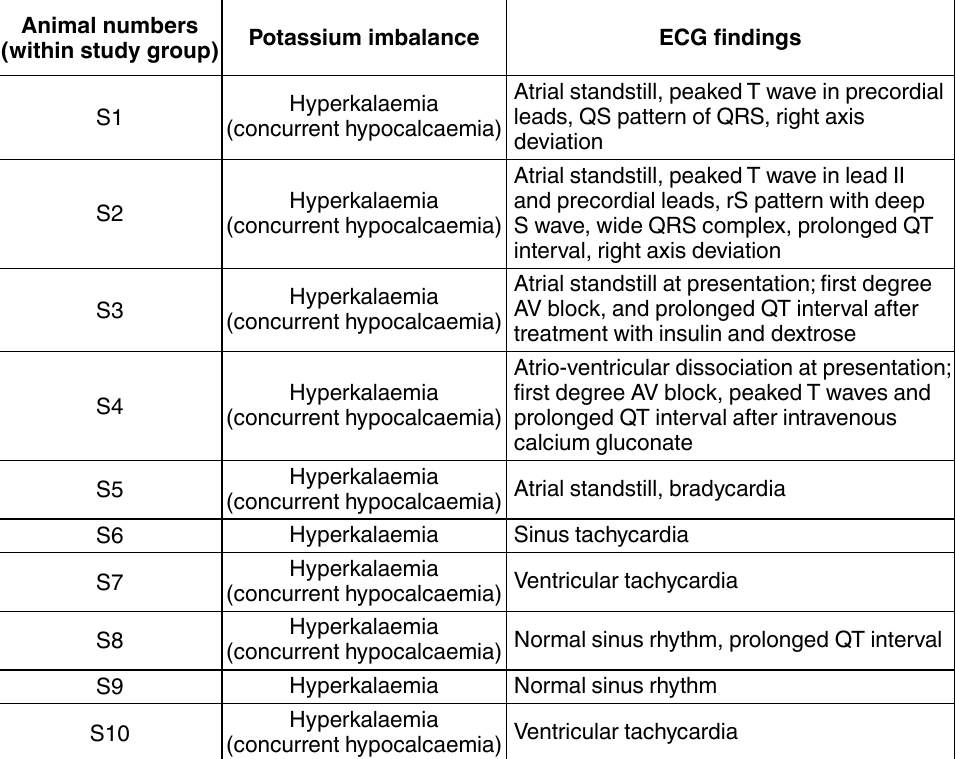
table 4. ECG changes in cats with hyperkalaemia animal numbers (within study